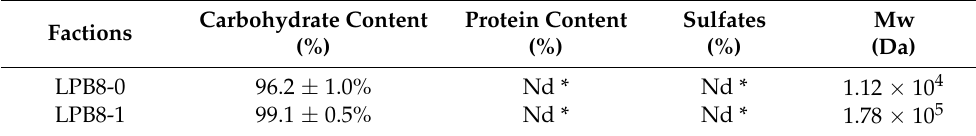
Table 1. Chemical compositions and basic properties of LPB8-0 and